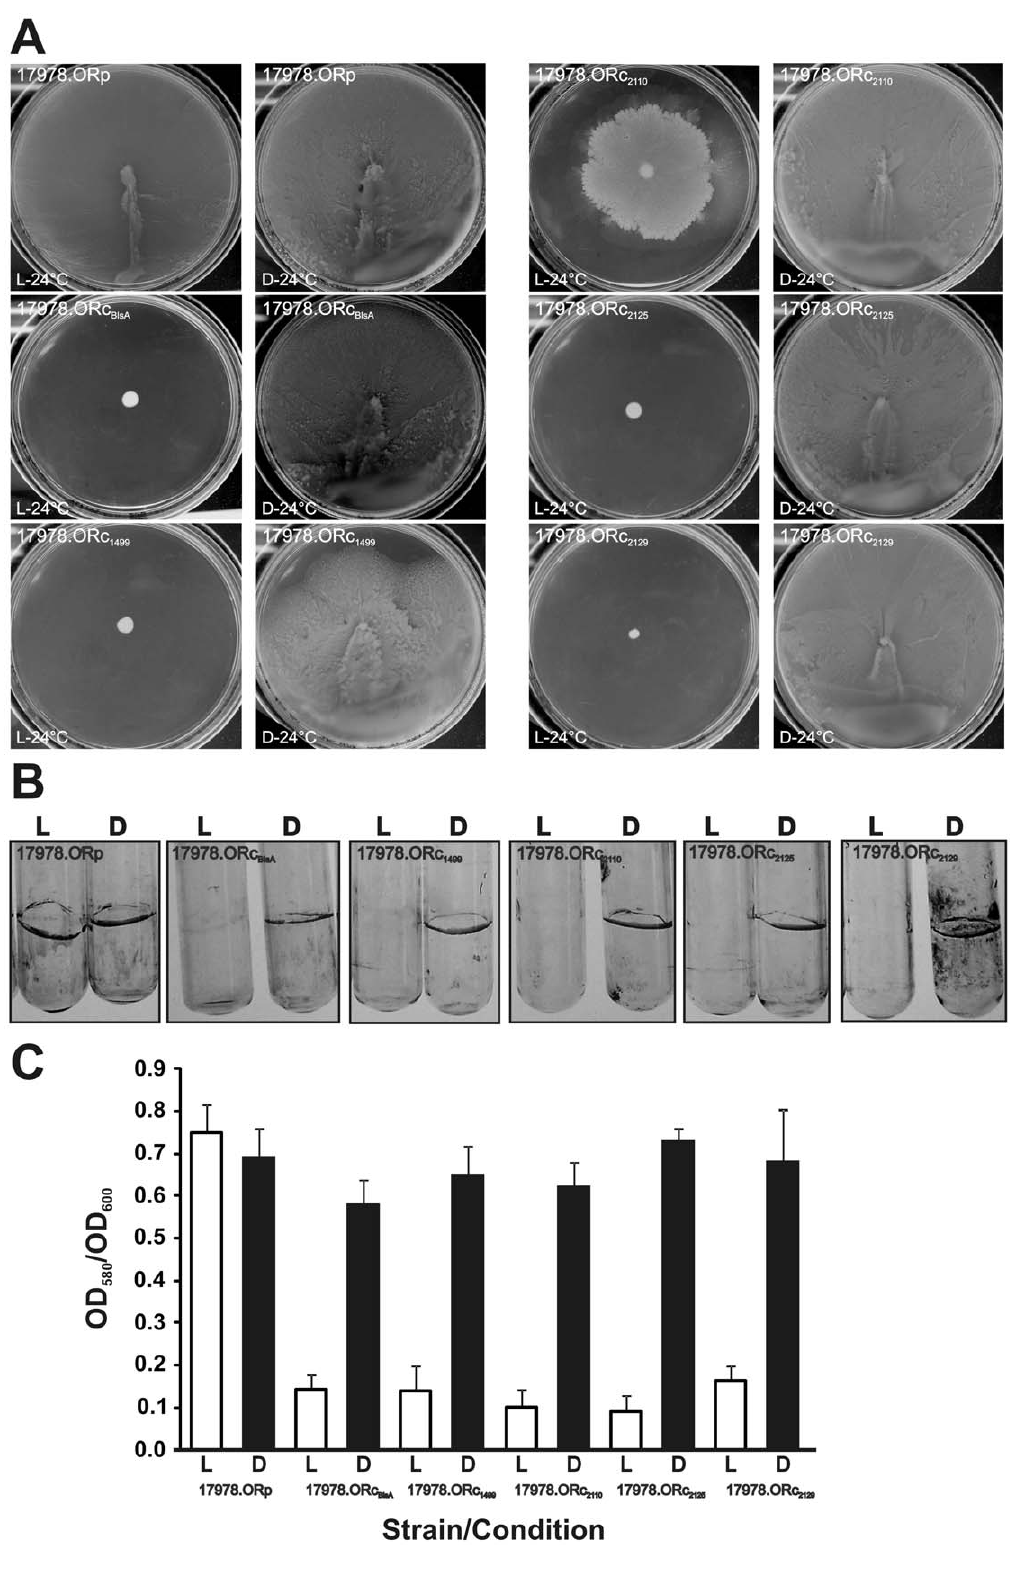
Figure 3. Effect of blue light on biofilm and motility mediated by A.baylyi s photoreceptors in an A.baumannii genetic background. A. Cells of the ATCC 17978.OR blsA mutant, transformed with plasmids pWH1499, pWH2110, pWH2125 and pWH2129 or the empty pWH1266 vector, were inoculated on the surface of swimming plates. Plates were inspected and photographed after overnight incubation in darkness (D) or the presence of blue light (L) at 24 u C. B. The biofilms formed by ATCC 17978.OR blsA mutant, transformed with plasmids pWH1499, pWH2110, pWH2125 and pWH2129 or the empty pWH1266 vector on glass tubes were recorded after static incubation for 96 h at 24 u Cby direct visual inspection and